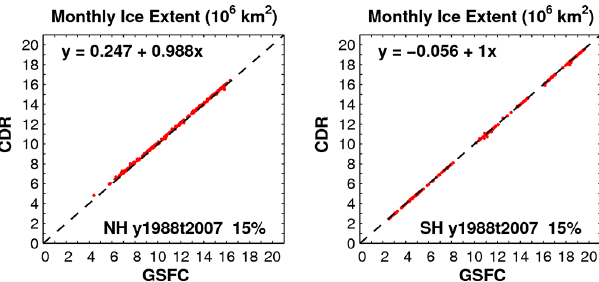
Figure 4. The scatter-diagram of sea ice extents (million square kilometers) based on monthly CDR and GSFC (20yr from January 1988 to December 2007). Left panel is for the Northern and the right is for Southern